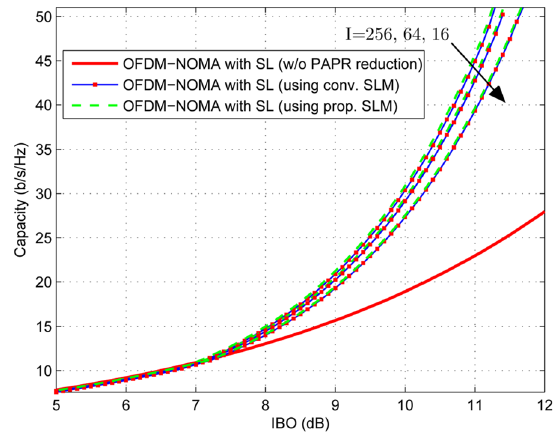
Fig. 7 Asymptotic upper limit of sum rate capacity versus IBO for DL OFDM-NOMA in the presence of nonlinear distortion before and after using conventional and proposed SLM techniques, with different number of alternatives I 16, 64 and 256 =